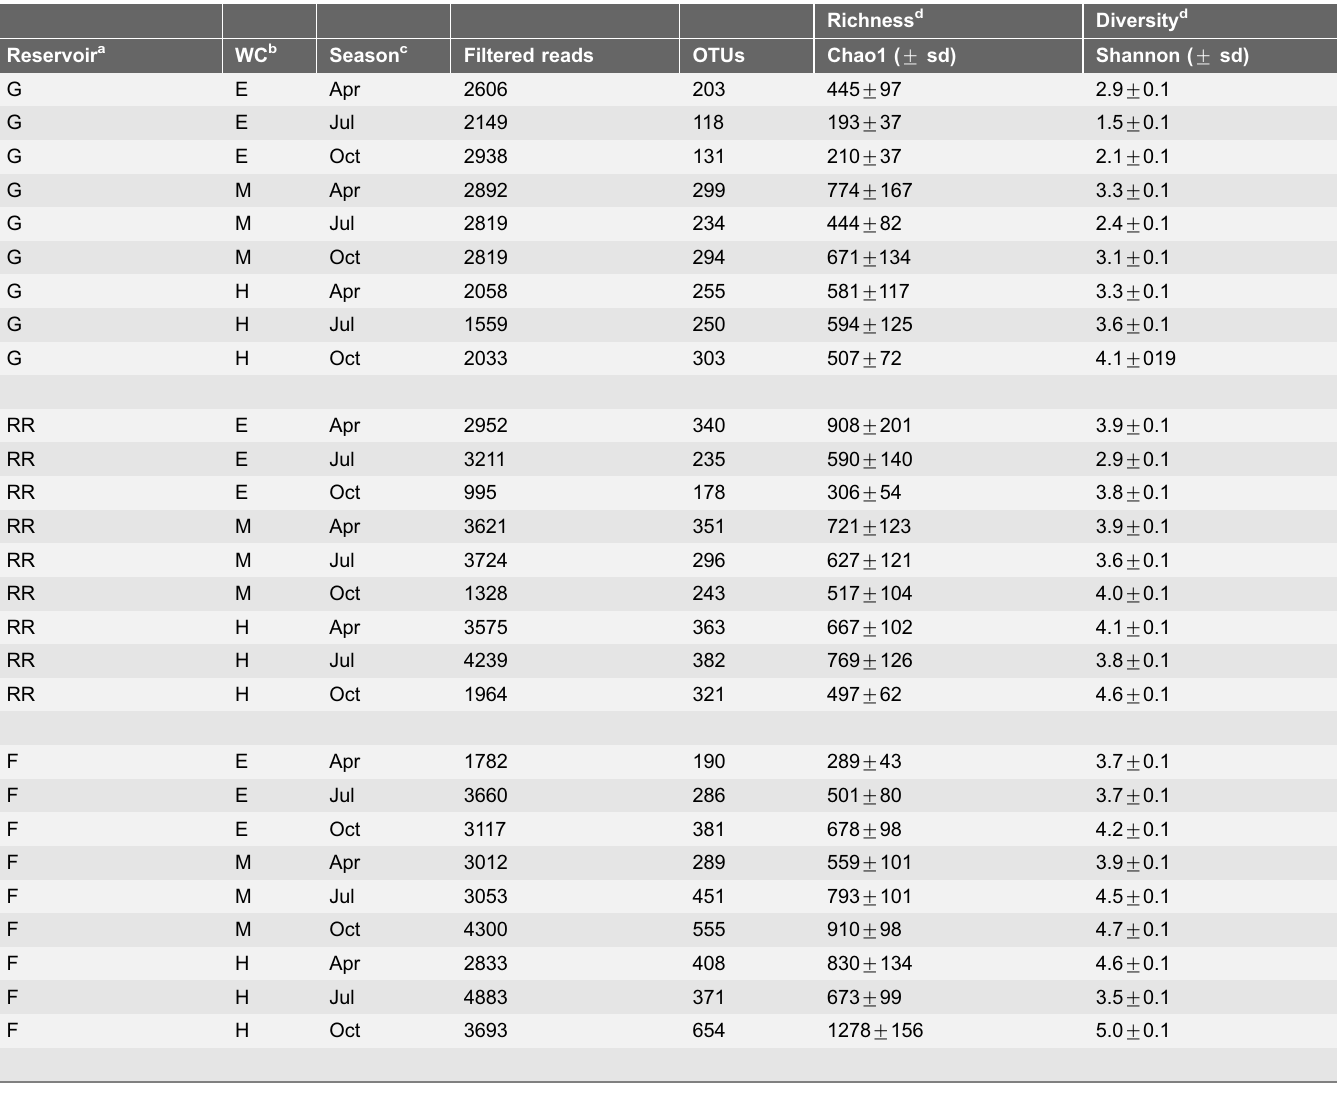
Table 2. Observed bacterial richness and diversity estimates based on OTUs for La Gileppe, Ry de Rome, and Fe´ronval